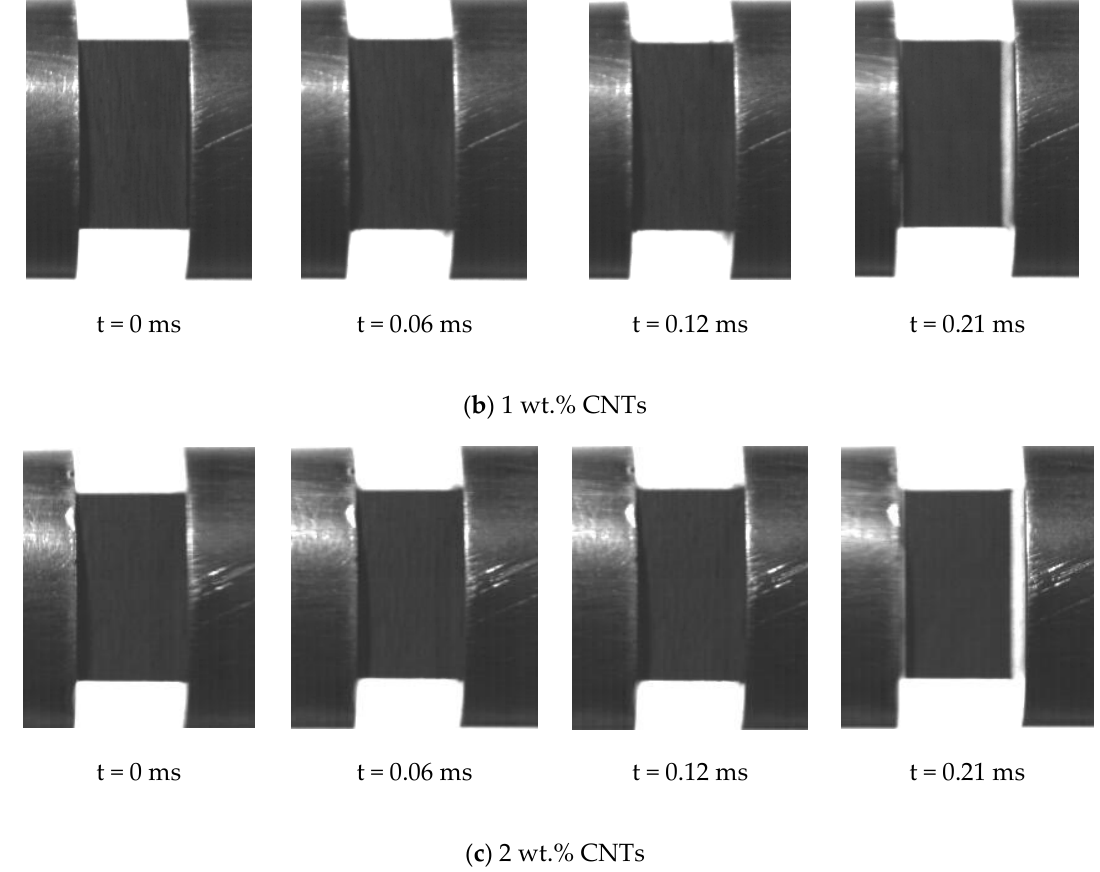
Figure 13. High-speed photograph of real-time dynamic compression test of nanocomposites with di ff erent CNTs mass fraction, P = 4 bar.